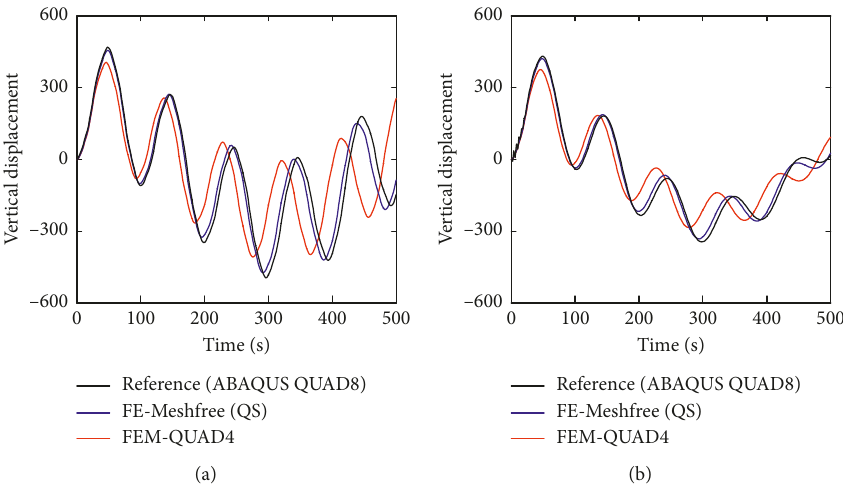
Figure 26: Transient response of cantilever beam subjected to harmonic loading with ω